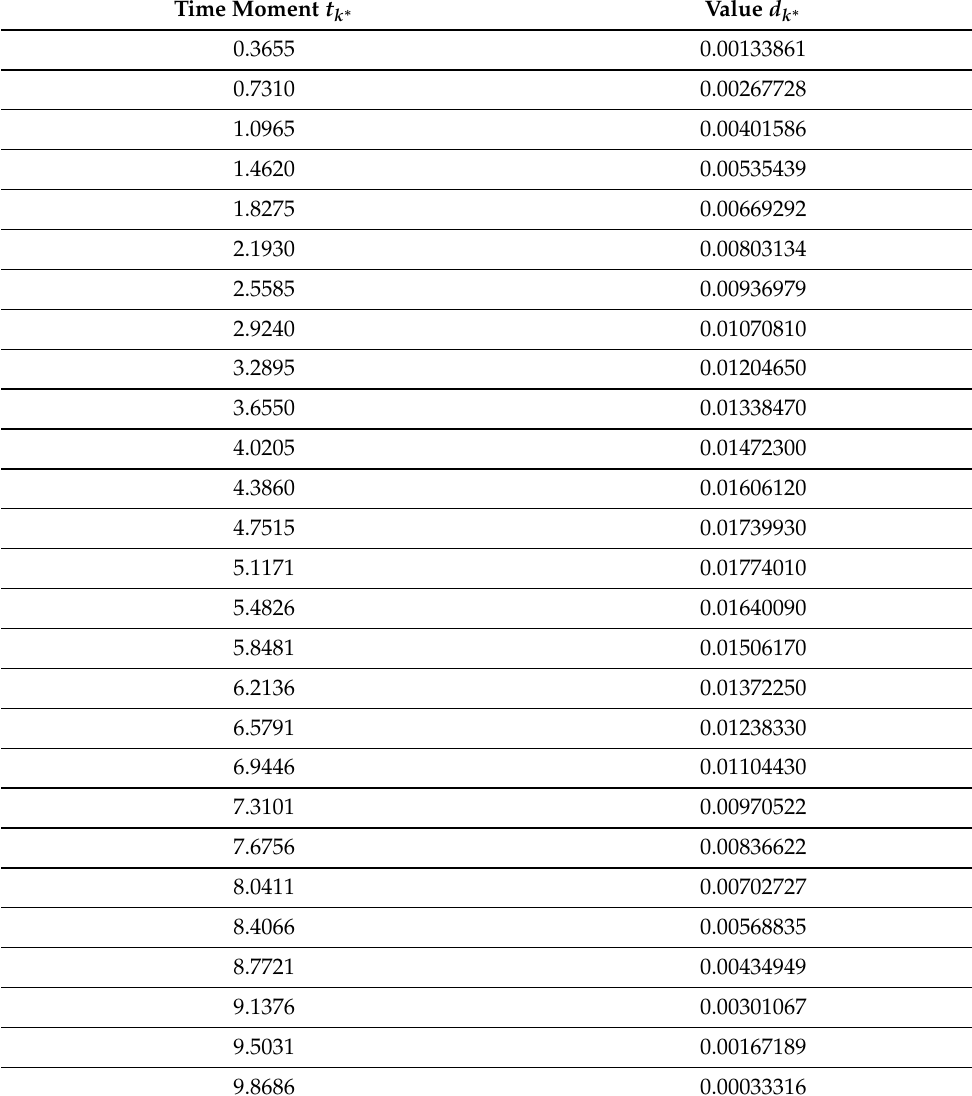
Table 2. The Poincaré recurrences for the point (10), ∆ t P = 10 − 4 , T = 40 for reaching the attractor. Time Moment t k